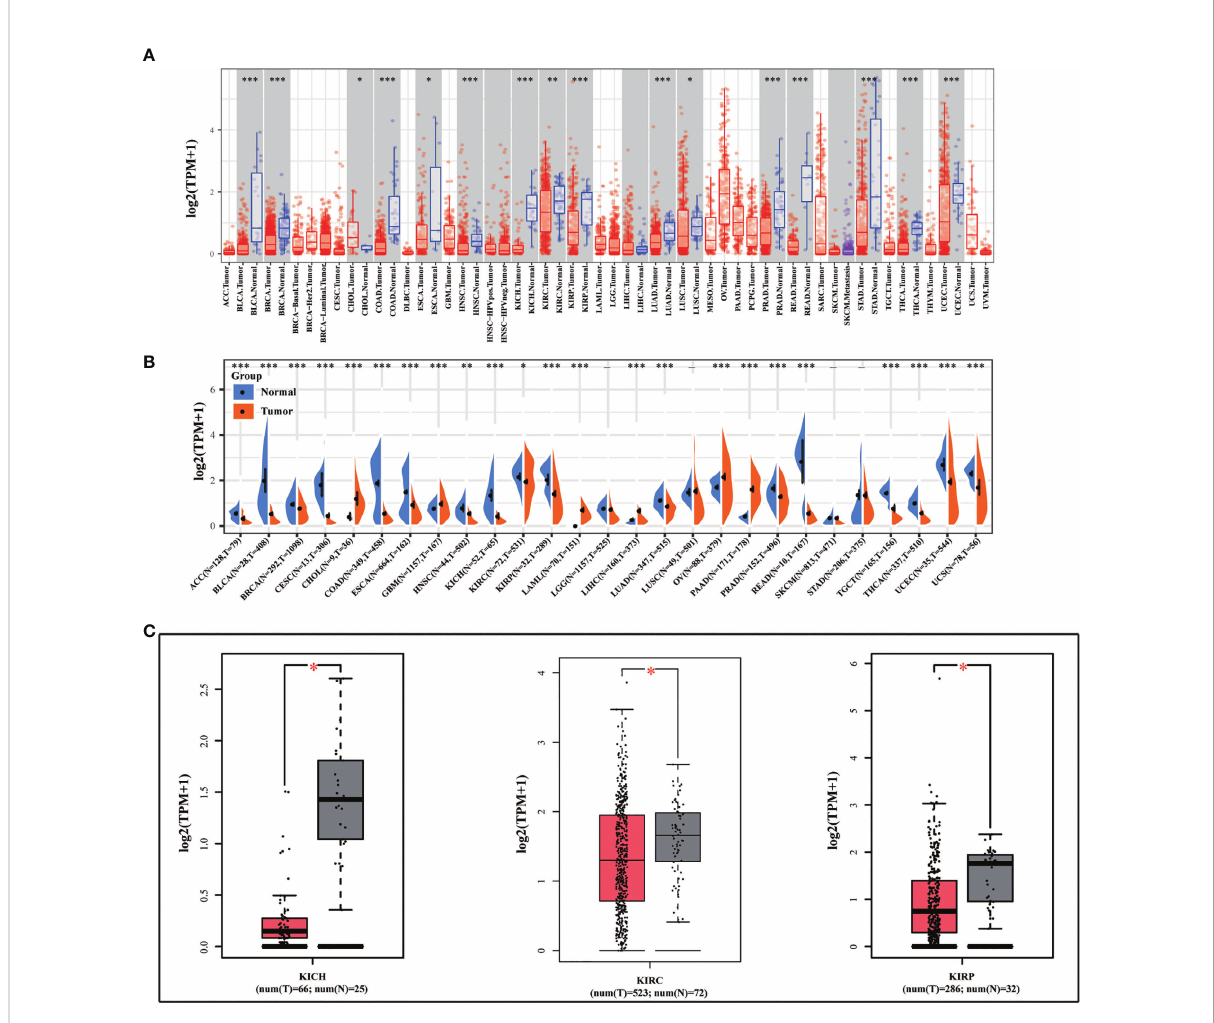
FIGURE 1 METTL24 was decreasingly expressed in KIRC tissues versus normal kidney tissues. (A) METTL24 expression in various cancers and normal tissues as analyzed using the TIMER database. (B) METTL24 expression in various cancers and normal tissues as analyzed using the data sets from TCGA and